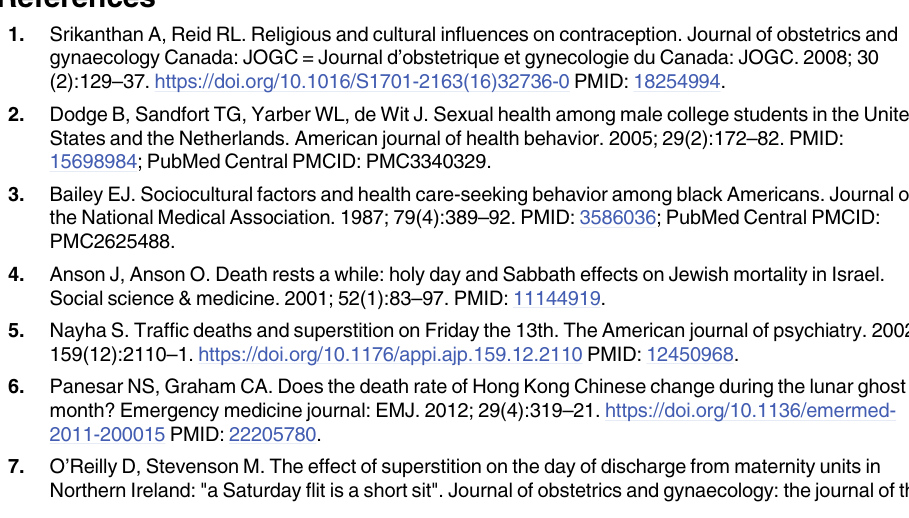
S1 Table. The numbers of surgeries performed in each lunar month from 2000 to 2011. S2 Table. Mixed model comparative analysis of the average number of surgery between each lunar month as the patients categorized according to location of residence and gen-